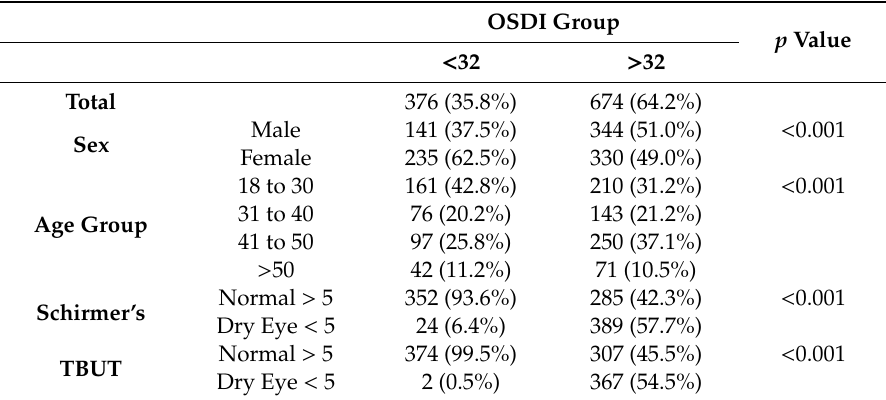
Table 3. Distribution of severe dry eye (OSDI > 32) by di ff erent factors.